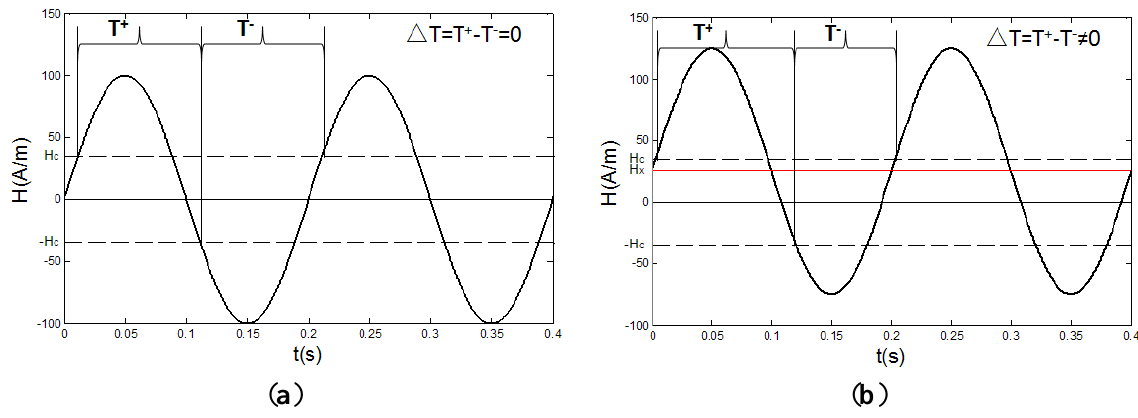
Figure 1. The schematic diagram of the output pulse signals: ( a ) there is no target magnetic field; ( b ) there is a target magnetic